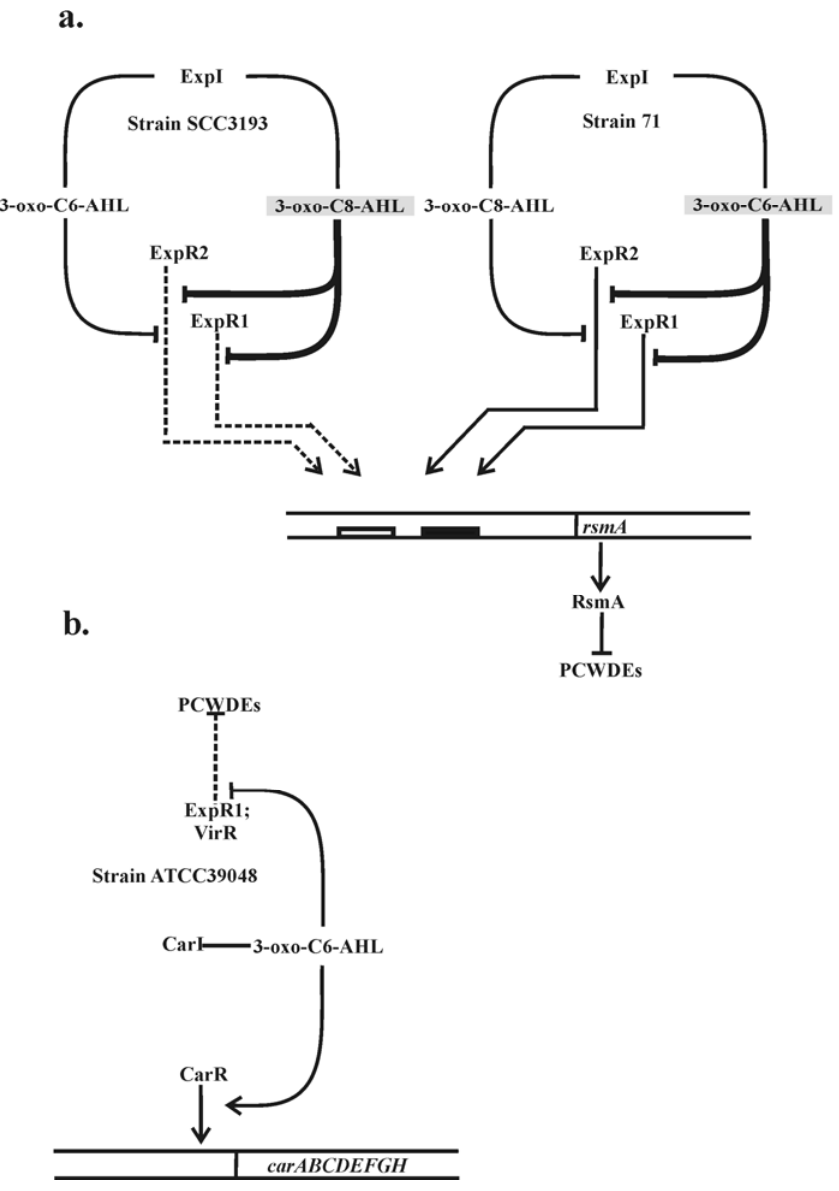
Figure 1. The AHL-mediated quorum sensing-dependent regulation of multiple target genes in Pectobacterium carotovorum . ( a ) Regulation of PCWDE production by ExpR1 and ExpR2 in Pcc strains SCC3193 (a class I strain) and 71 (a class II strain). ( b ) A schematic model for regulation of carbapenem production in Pcc strain ATCC39048 (a class II strain) by CarR in a signal-dependent way. The major AHL species produced by the Pcc strains SCC3193 and 71 are shown on gray background and their effects are indicated by bold lines. Inhibitory effects are indicated by ┤ and arrows indicate a stimulatory effect. Not all molecular mechanisms encompassed by this model are fully characterized (indicated on the figure with dashed